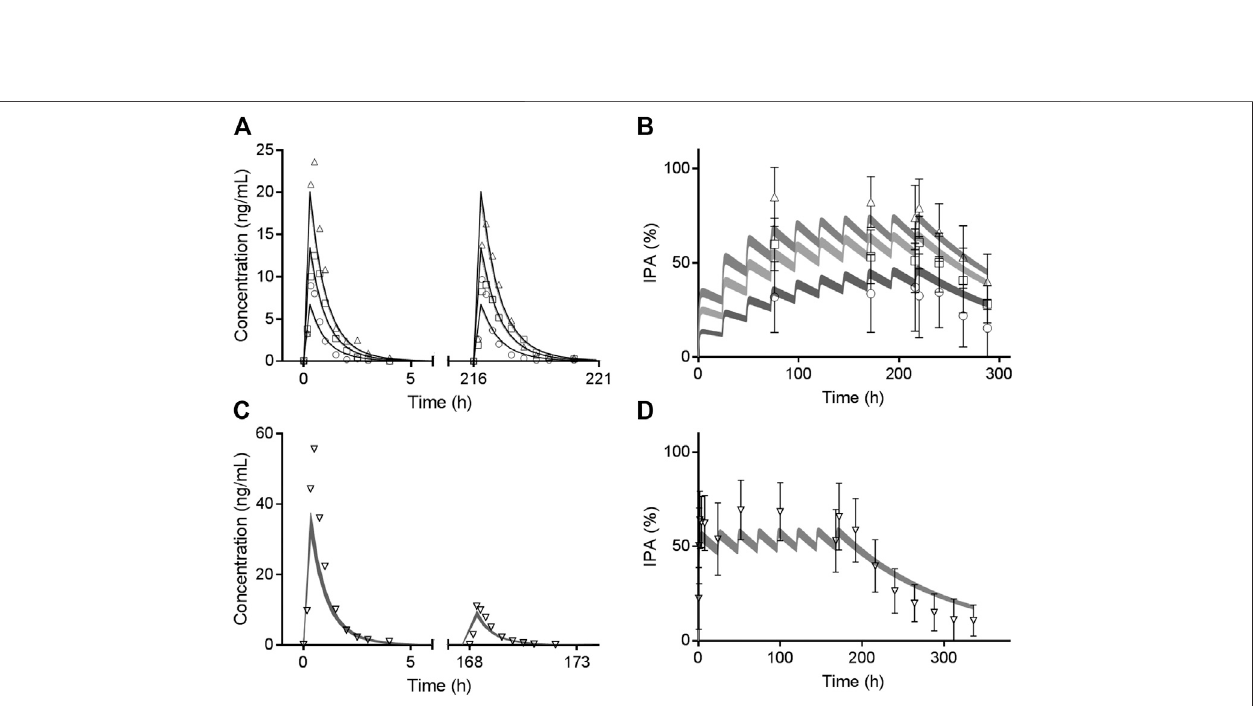
FIGURE 3 | Observed mean value (symbols) and simulated 95% con fi dence interval (bands) of AM-H4 concentration (left row) and IPA (right row) vs. time following different doses of vicagrel according to Trial 4. Different shades of gray bands refer to corresponding observed values of different doses. Observed IPAs are presented as mean ±